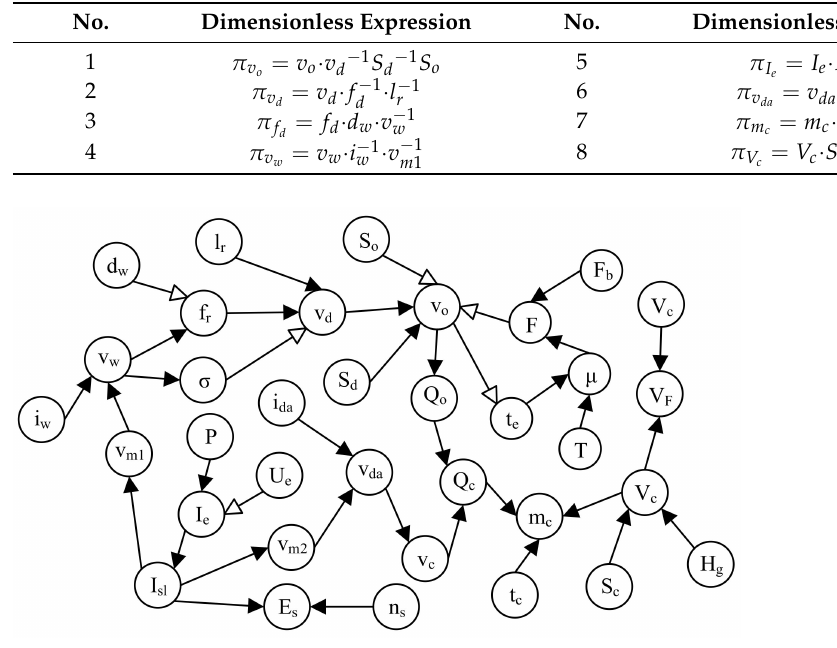
Figure 15. Physical parameter logic network of the bulk TCM